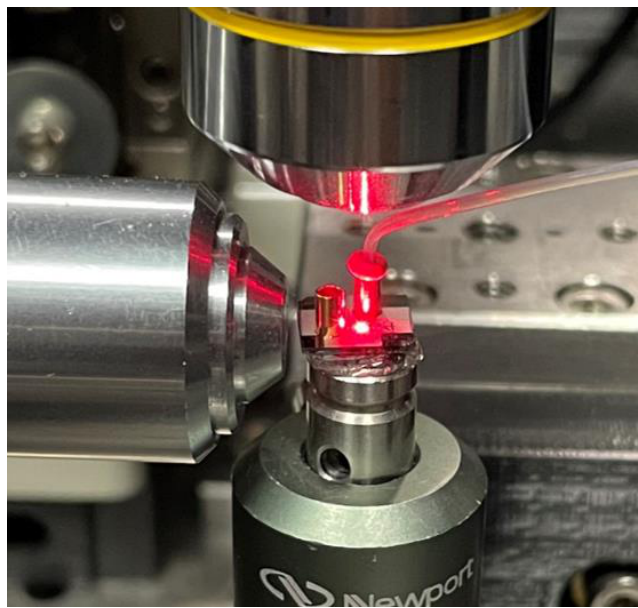
Figure 7. Test setup of an optofluidic biosensor chip in a top-illumination format. One copper bead is used as a sample reservoir and is attached to the channel inlet. A second copper bead connects the channel outlet to a vacuum to instigate fluid flow. A laser illuminates the channel excitation region from above (a side-illuminated chip will have a fiber connected to the laser and connects it to a planar ridge waveguide). On the left is an objective that collects the fluorescence signal and focuses it onto the APD.